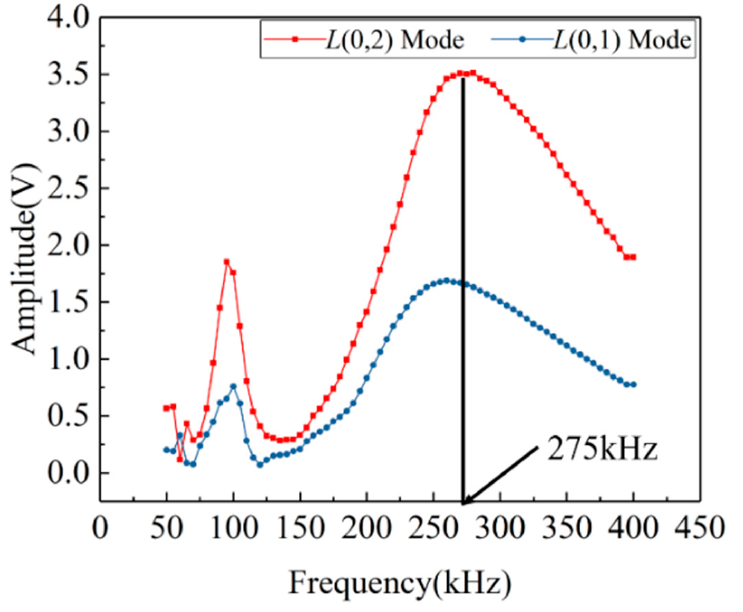
Figure 7. Amplitude–frequency characteristics of L (0,1) and L (0,2) modes.